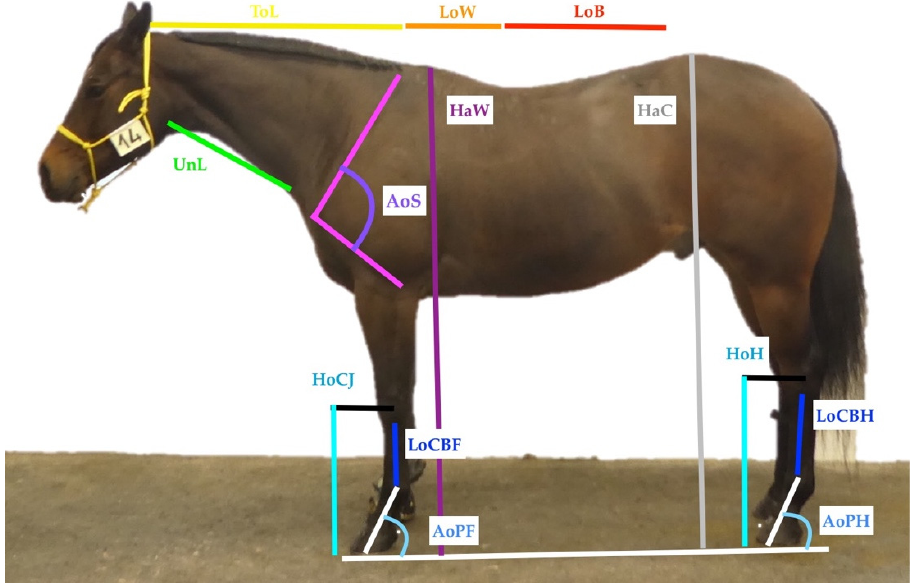
Figure 1. Positioning of the linear measurements. Abbreviations: Height at Withers (HaW), Height at Croup (HaC), Topline (Tol), Underline (UnL), Angle of shoulder (AoS), Length of withers (LoW), Length of back (LoB), Height of carpal joint (HoCJ), Height of hock (HoH), Length of cannon bone forelimb (LoCBF), Length of cannon bone hindlimb (LoCBH), Angle of pastern forelimb (AoPF), Angle of pastern hindlimb (AoPH).